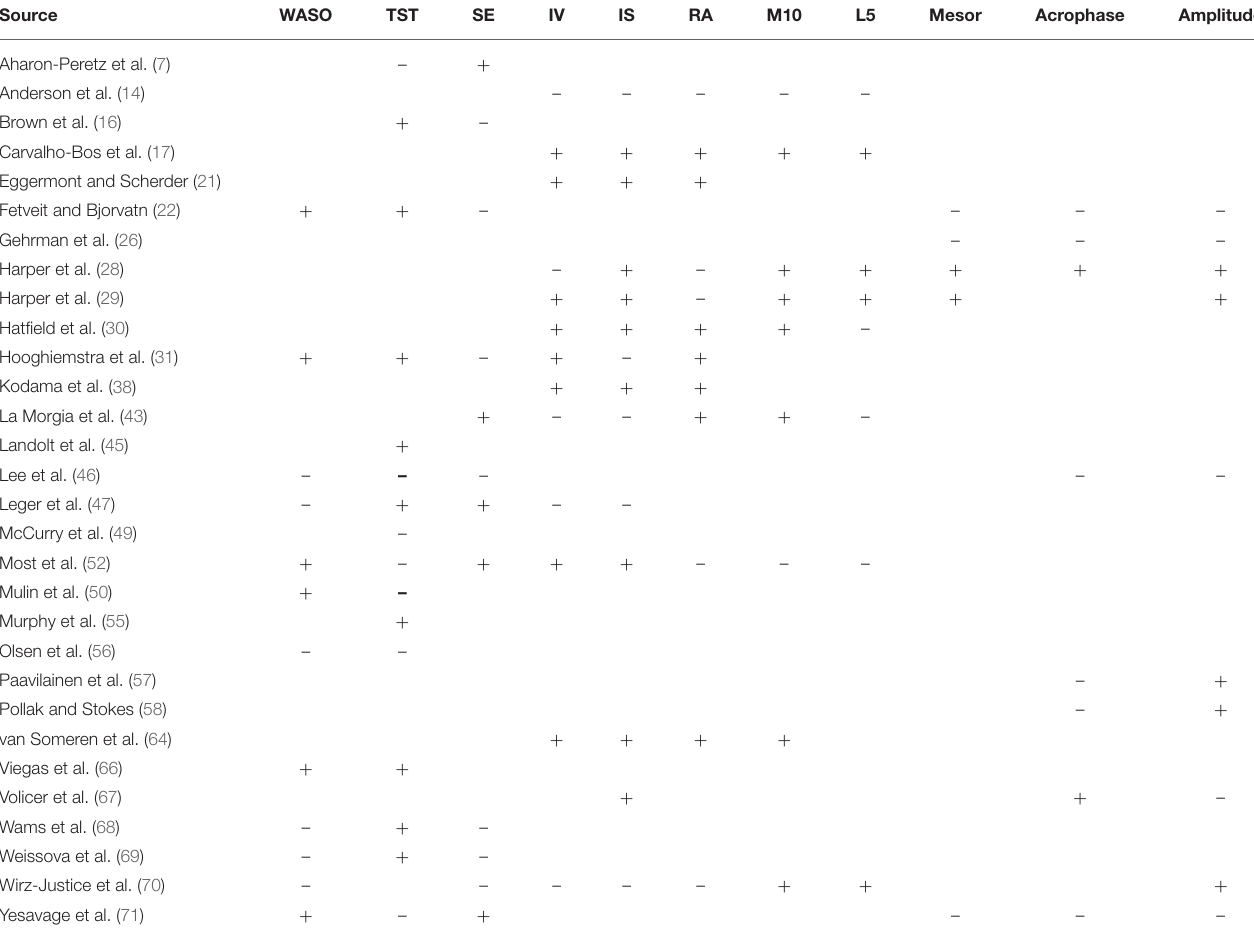
TABLE 4 | Specific outcome measures of sleep and circadian rhythm reported by included studies. Source